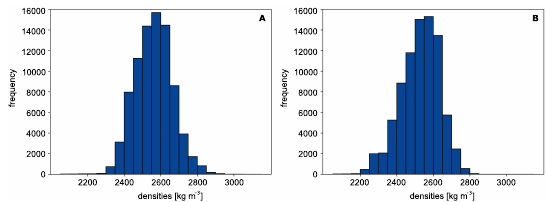
Figure 5. Frequency of the globally determined bulk densities. (A) Histogram of global crustal density estimates from correlation analysis. (B) Histogram of global crustal density estimates from Bouguer anomaly roughness.